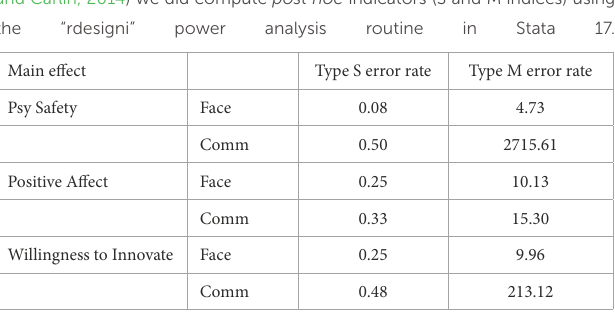
FIGURE 1 (A) Box plot of impact of face threat on psychological safety. (B) Box plot of impact of commitment on psychological